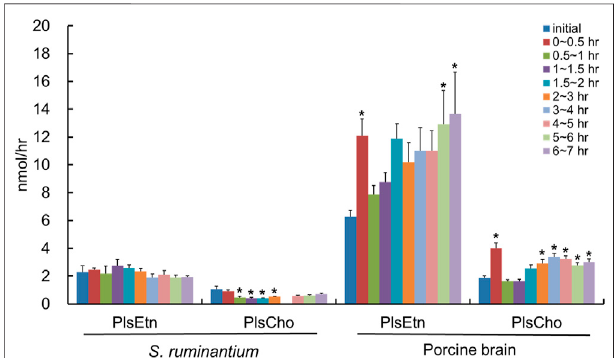
FIGURE3 | Total amounts of PlsEtn and PlsChoin thelymphof thoracic lymph-cannulated rats for 7 h after duodenal administration of the emulsion containing lipids extracted from S. ruminantium or porcine brain. Lipids extracted from S. ruminantium and porcine brain were adjusted to the sameamountintotallipidswhentheduodenaladministrationwasconducted. Data are represented as mean ± SEM ( n = 5 – 6). Asterisk indicates signi fi cant difference with respect to the values at time 0 ( p <